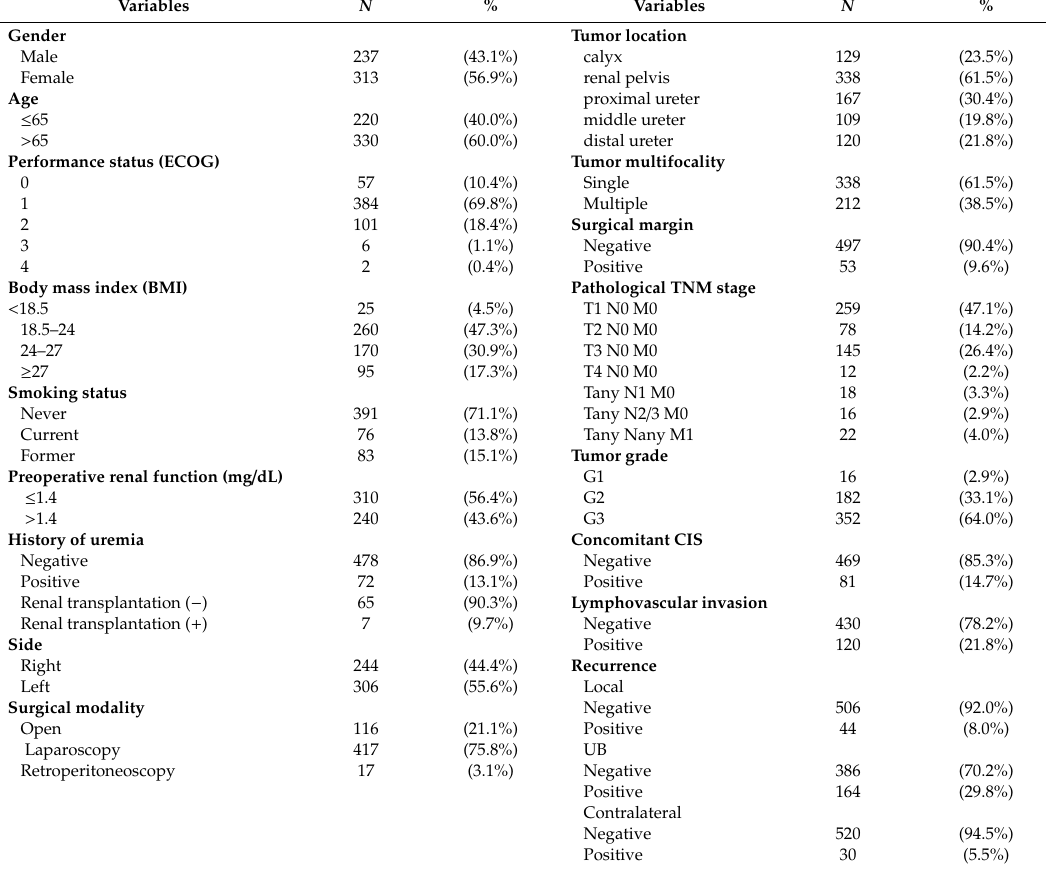
Table 1. Clinicopathological characteristics of 550 patients with UTUC after